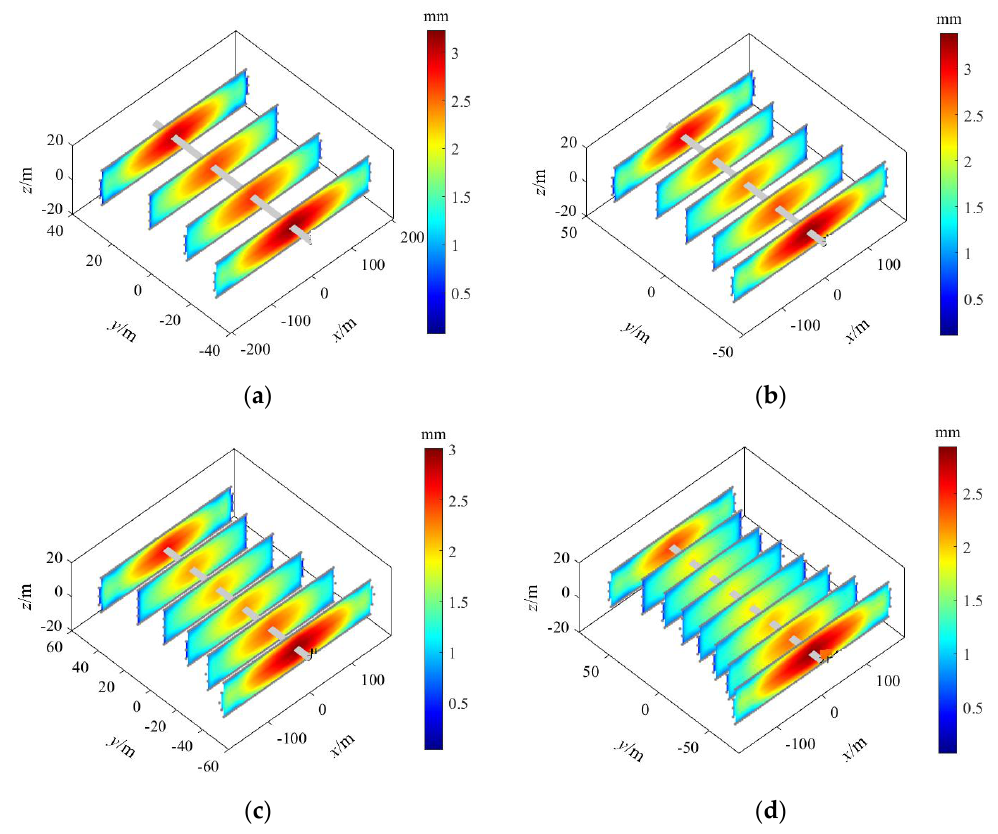
Figure 8. Multi-cluster crack propagation patterns under different cluster numbers. ( a ) 4 clusters, Cluster spacing 20 m; ( b ) 5 clusters, Cluster spacing 25 m; ( c ) 6 clusters, Cluster spacing 20 m; ( d ) 8 clusters, Cluster spacing 15 m.